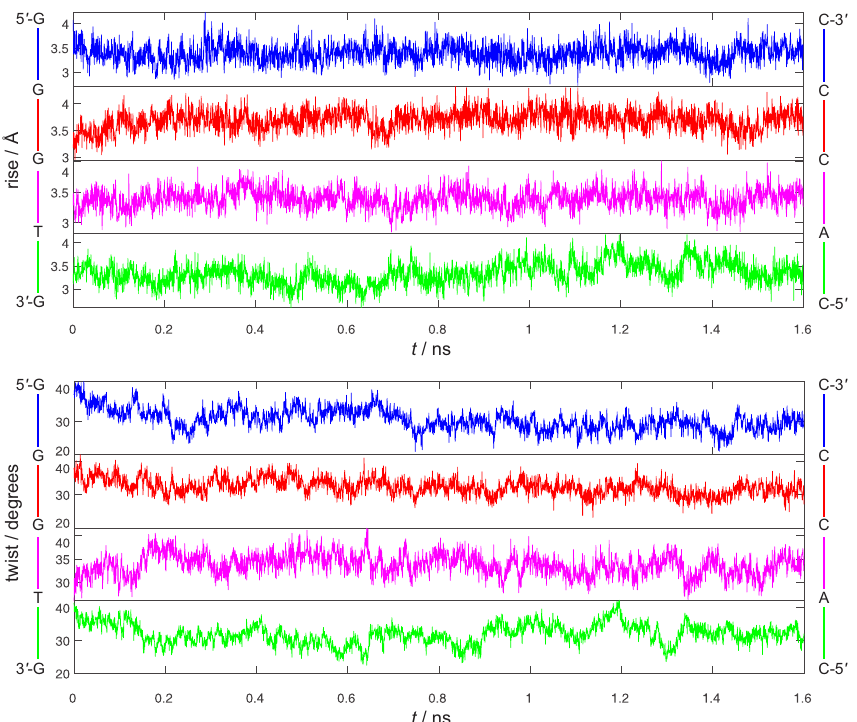
Figure 5. Time evolution of the four rise (Å, top ) and twist (degrees, bottom ) coordinates of ds-5 (cid:48) - GGGTG-3 (cid:48) during 1.6 ns dynamics simulations in